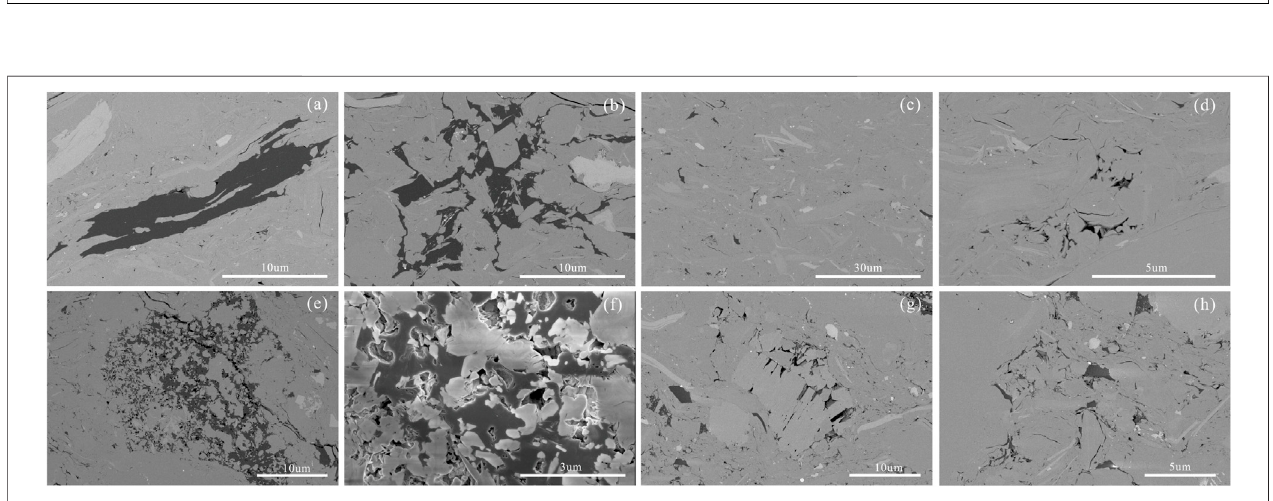
FIGURE9| SEM images ofORAshale samplesin theShahezi Formation. (A – D) LFS1-13; (E – H) LFS1-20. (A) Organic debriswith littleinternal pores; (B) bitumen withlittleinternalpores; (C) shrinkagegapsbetweenclaymineralsareundeveloped; (D) shrinkagegapsbetweenclaymineralsandintergranularpores; (E) internalpores developed locally in bitumen; (F) internal and marginal pores in bitumen; (G) dissolution pores in feldspar grains; (H) shrinkage cracks of clay minerals.